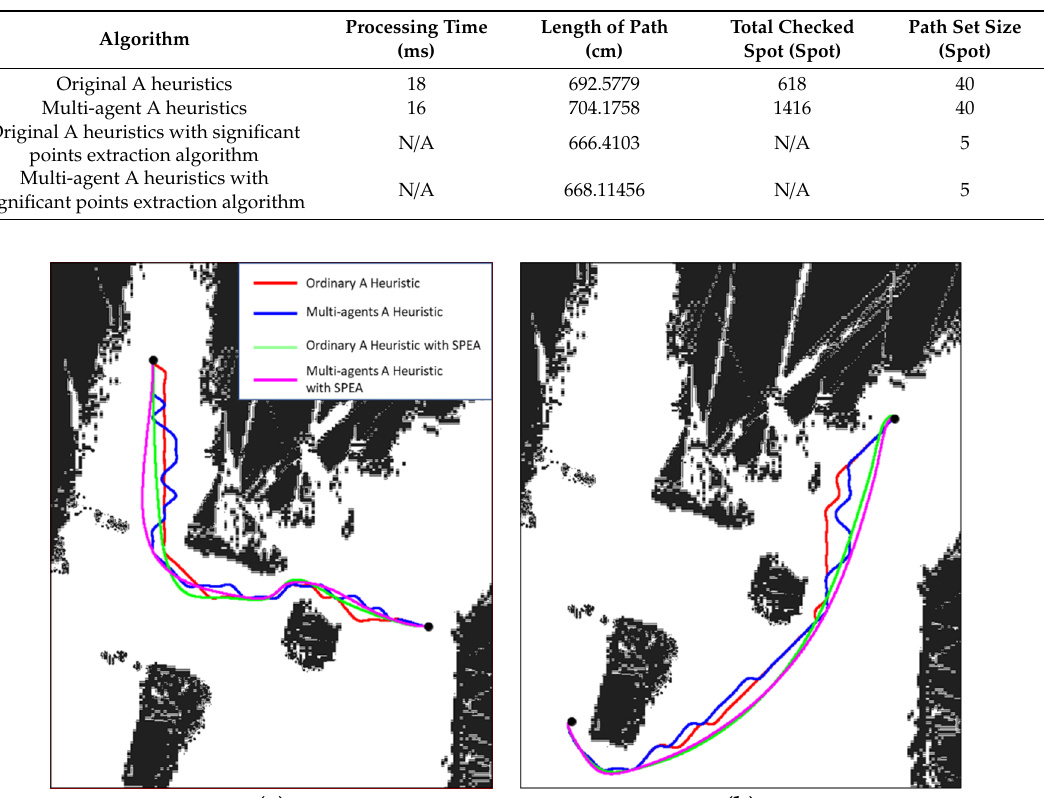
Figure 18. ( a ) Trajectories produced by fed the path point set of different algorithms to the C2 PCBC generator in the first scenario, ( b ) in the second scenario.